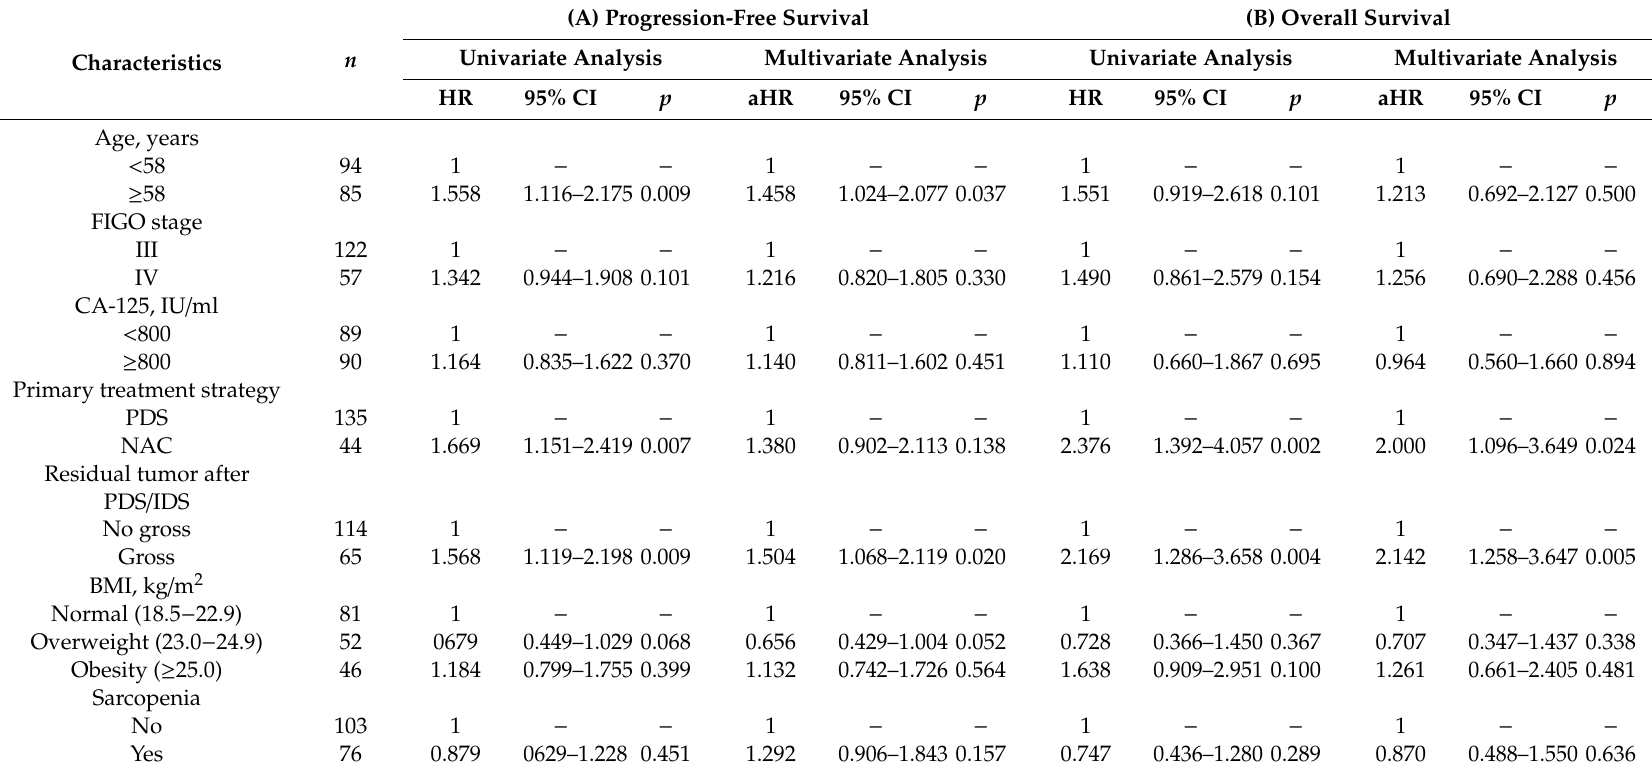
Table 3. Factors associated with patients’ survival